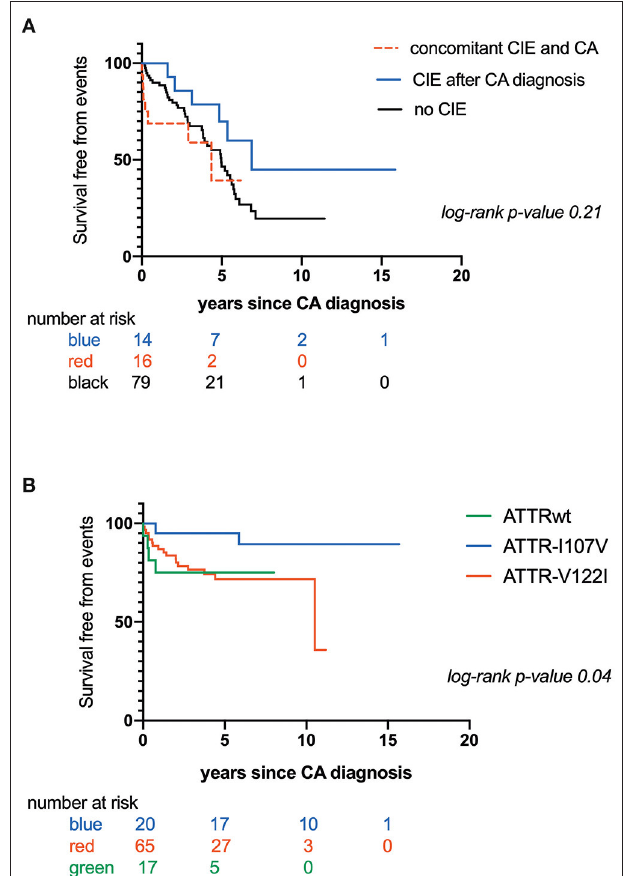
FIGURE 1 | (A) Kaplan-Maier analysis of survival free from mortality according to occurrence and timing of Cerebral Ischemic events (CIE); (B) Kaplan-Maier analysis of survival free from Cerebral Ischemic events (CIE) according to transthyretin cardiac amyloidosis (CATTR) genotype.